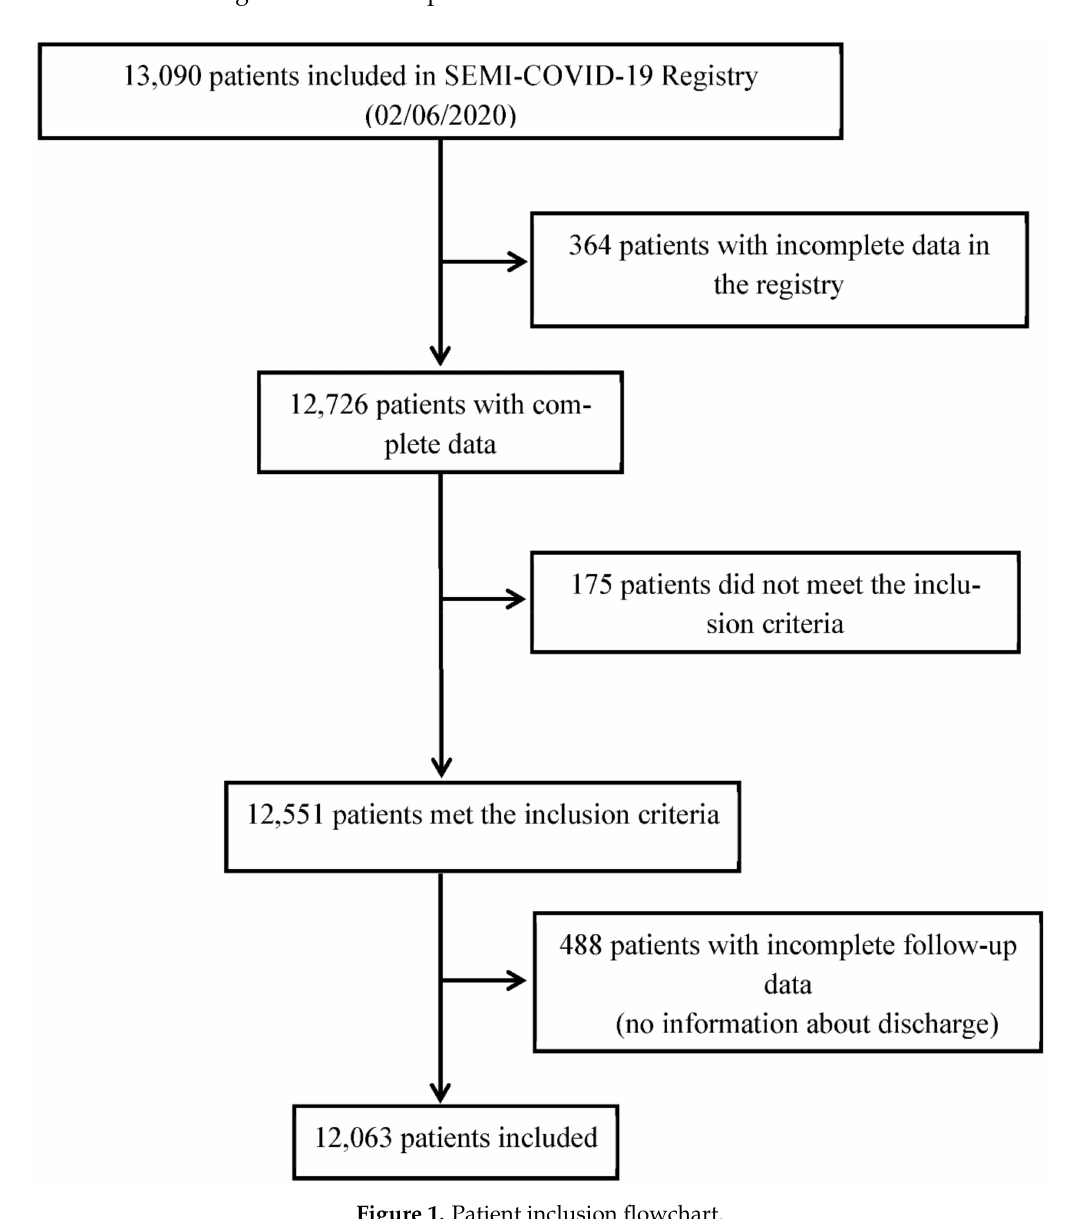
Figure 1. Patient inclusion